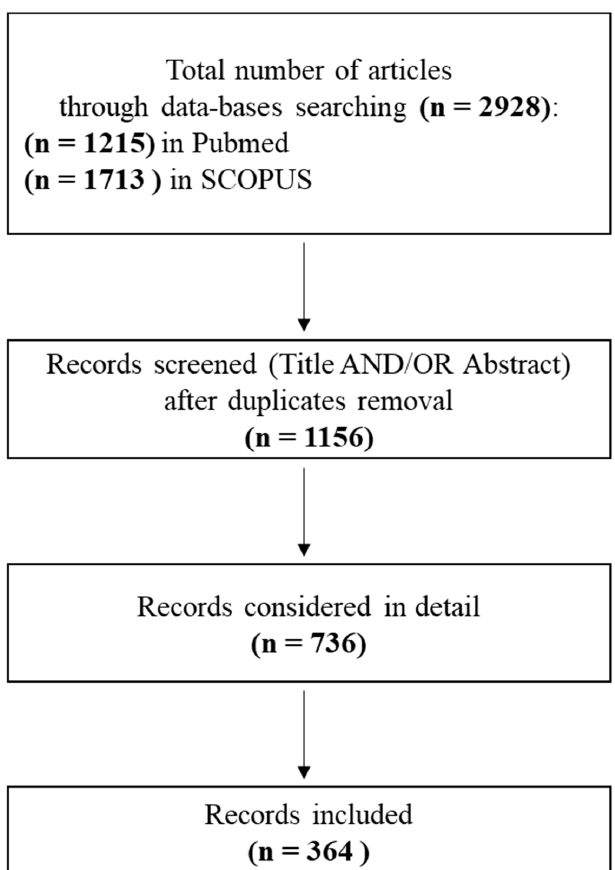
Figure 1. Flow diagram showing the literature search criteria adopted.